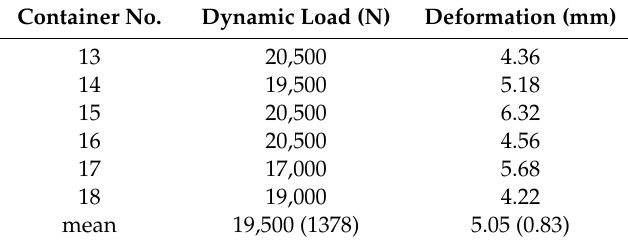
Table 6. Dynamic compressive strength